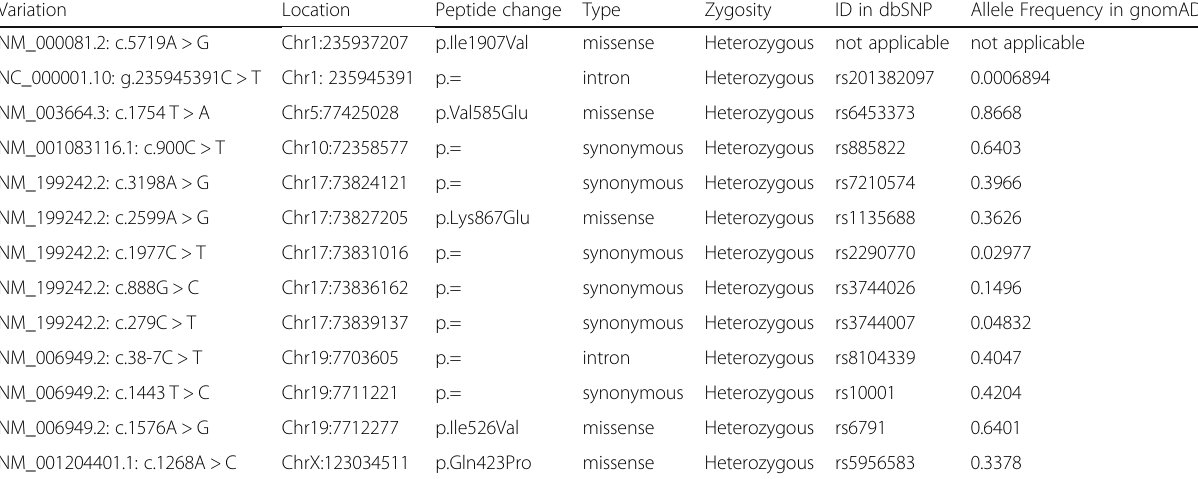
Table 1 Identified variations from the patient with CHS